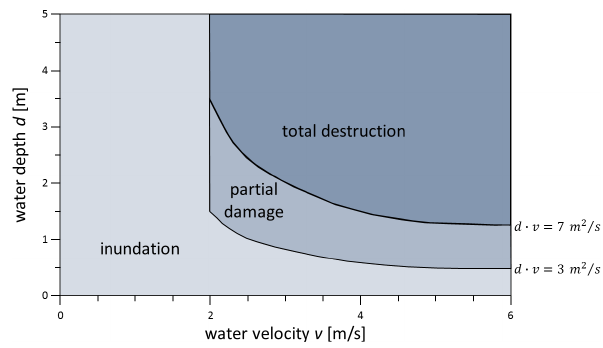
Figure 5. Identification of risk classes for different values of flow intensity for buildings (from Clausen and Clark,